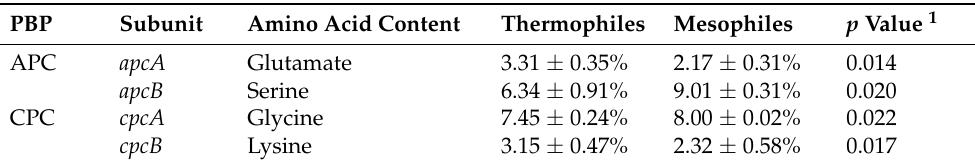
Table 2. Comparisons of amino acid content of each PBP polypeptide between thermophiles (the 19 thermophilic cyanobacteria investigated in this study) and mesophiles ( Synechocystis PCC 6803 and Synechococcus PCC 7942). PBP Amino Acid